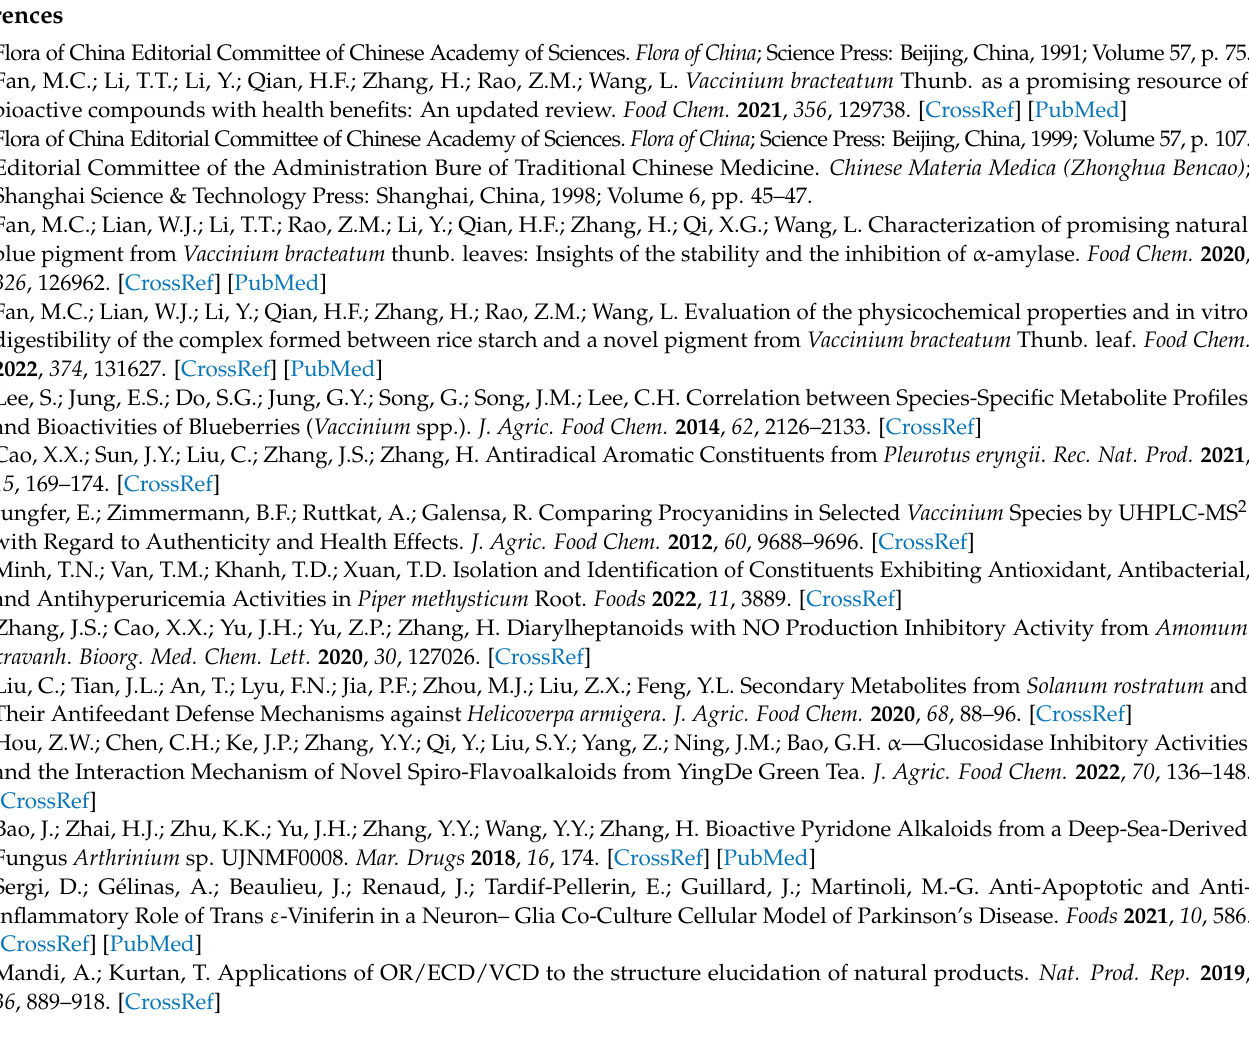
Table S4: Structural classes of all the isolated